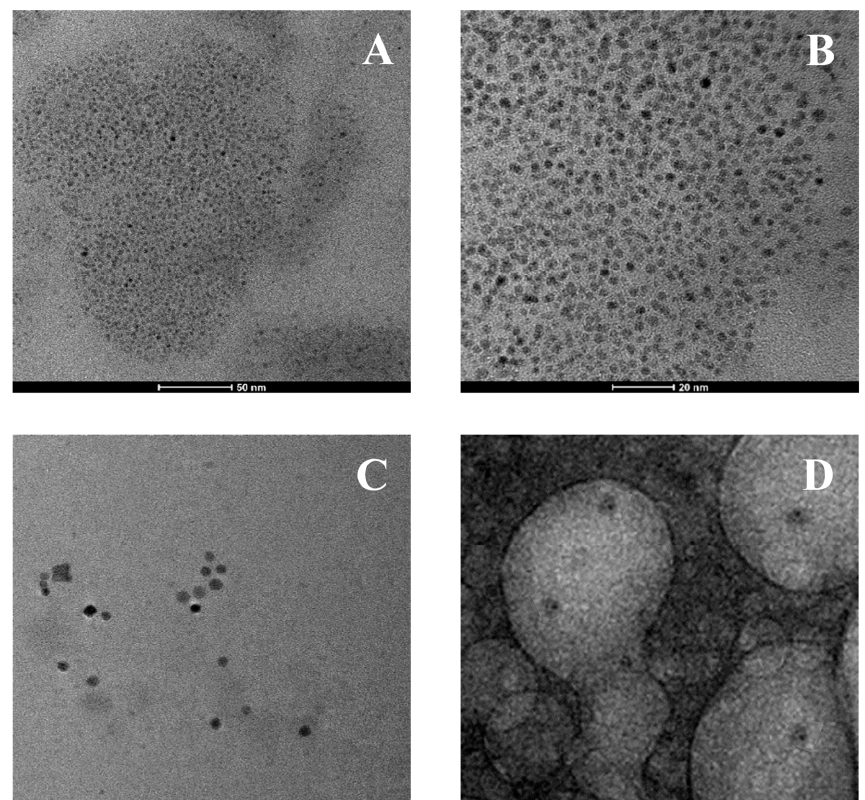
Figure 16. TEM micrographs of SeNPs produced by the 5AG strain in the complex matrix, scale bar: 50 nm and 20 nm (panels ( A , B )); the glucose matrix, scale bar: 50 nm (panel ( C )); and the molasses matrix, scale bar: 50 nm (panel ( D )).